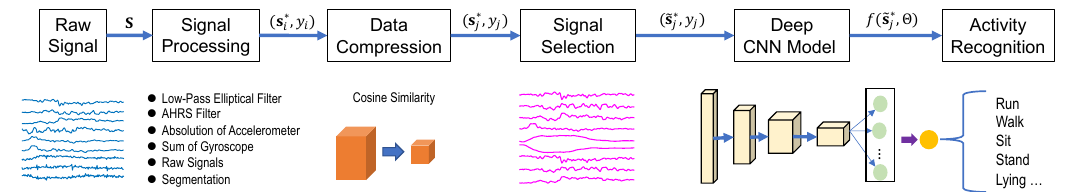
Figure 3. The structure and data stream of the fast and robust deep convolutional neural networks (FR-DCNN) for complex human activity recognition (HAR). The signal processing module is to extend the dimension of raw signals and label the divided segments. The data compression module aims to remove similar components for fast computation. The signal selection module is to choose the useful signals for high-accuracy classification. The new designed DCNN algorithm is to build the DL classifier for the next step—activity